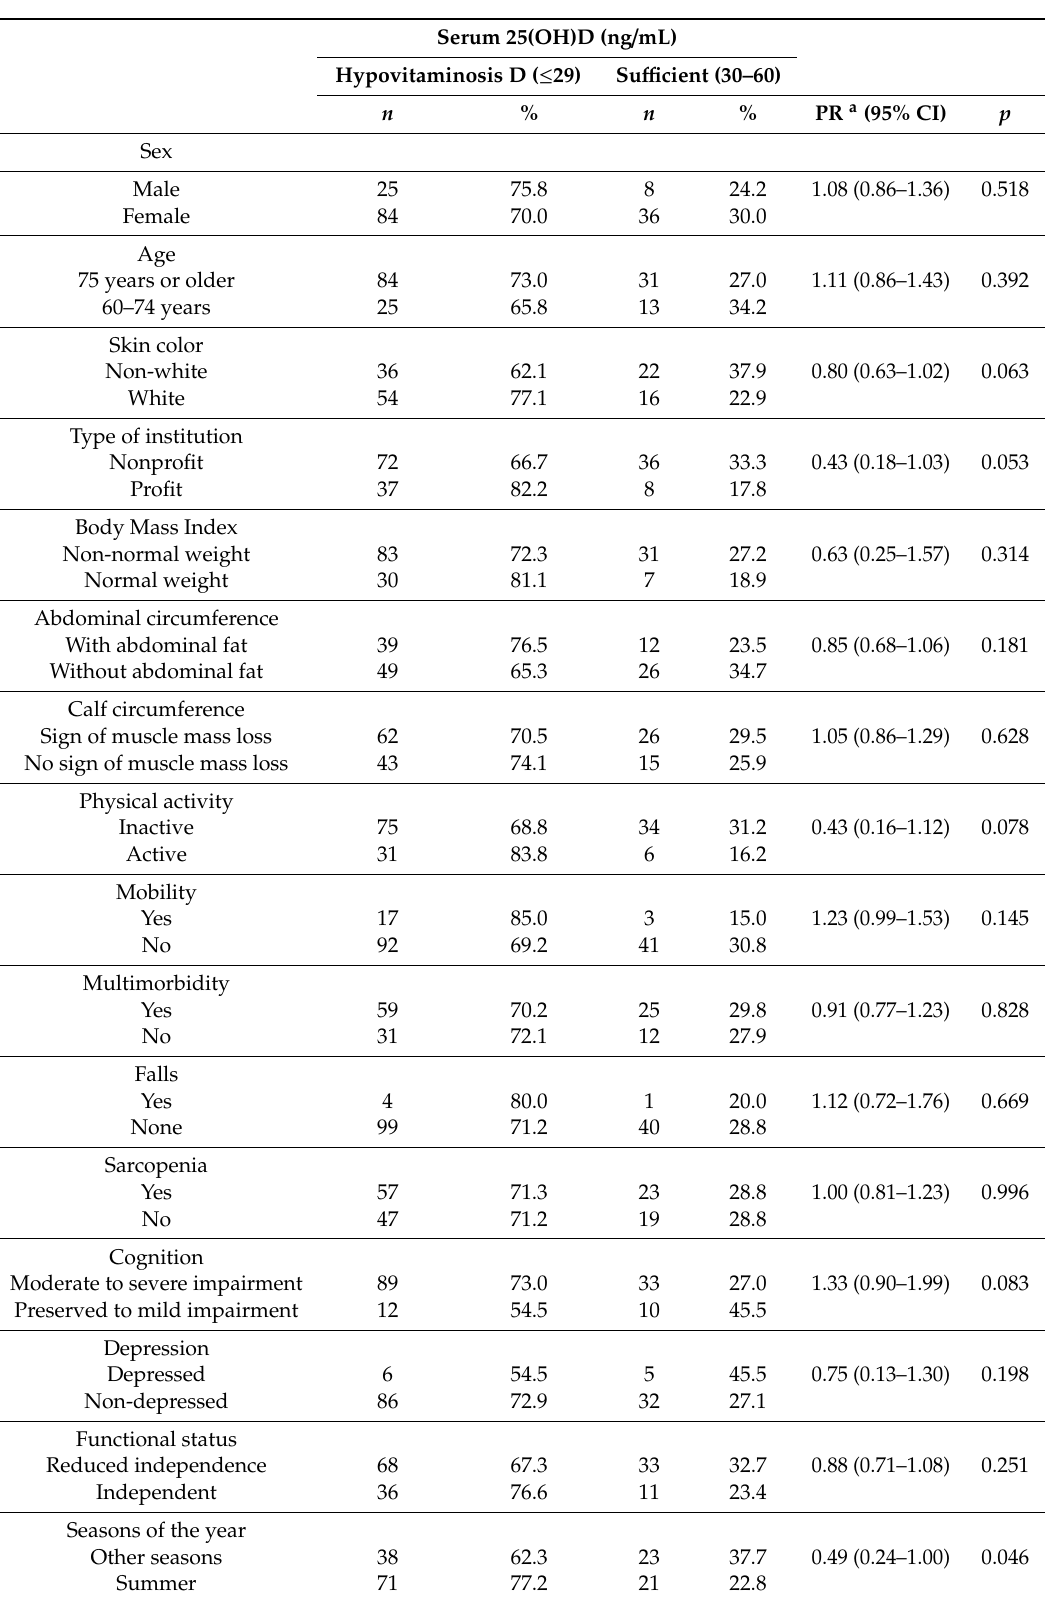
Table 3. Association between serum 25(OH)D concentration and variables of the theoretical